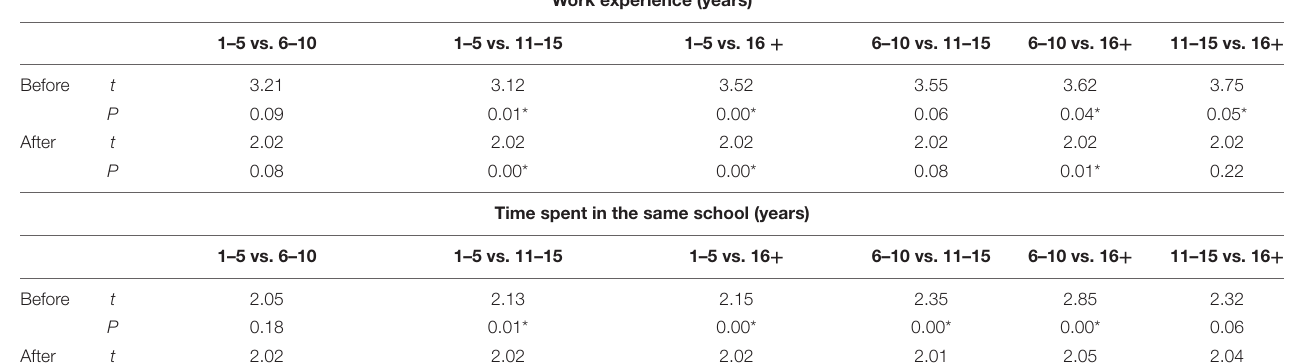
TABLE 6 | Post-hoc t -test results.